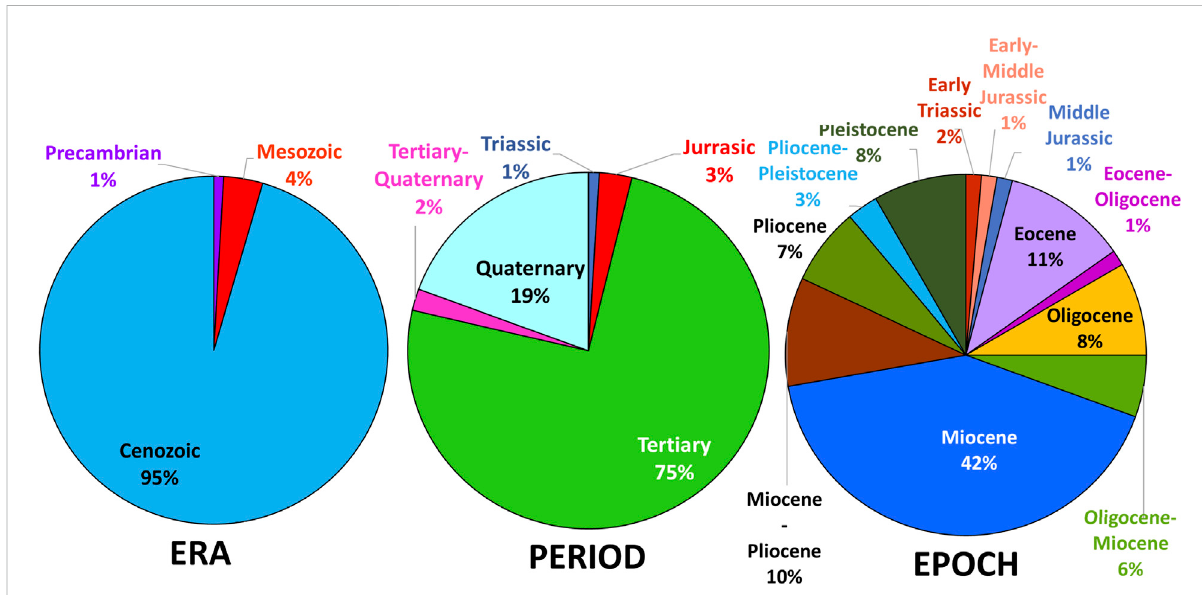
FIGURE 5 Age of erionite host rocks, classi fi ed by geological era, geological period, and geological epoch. The majority of rocks that erionite has crystallized in are younger rocks formed in the Cenozoic Era, primarily within the Miocene (i.e., 23 – 5.3